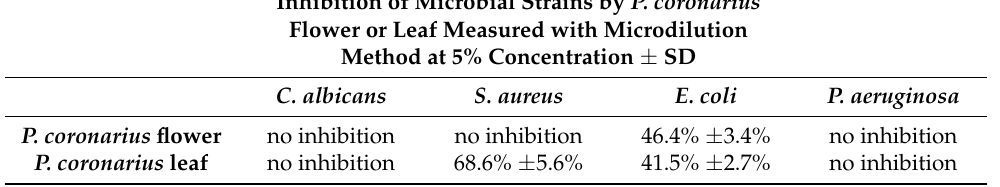
Table 5. Inhibition of different microbes by P. coronarius leaf or flower. Inhibition of Microbial Strains by P.